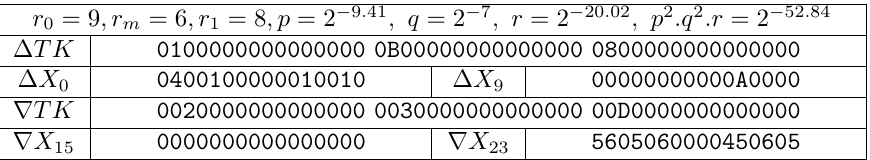
Table 12: Specification of boomerang distinguisher I for 23 rounds of SKINNY